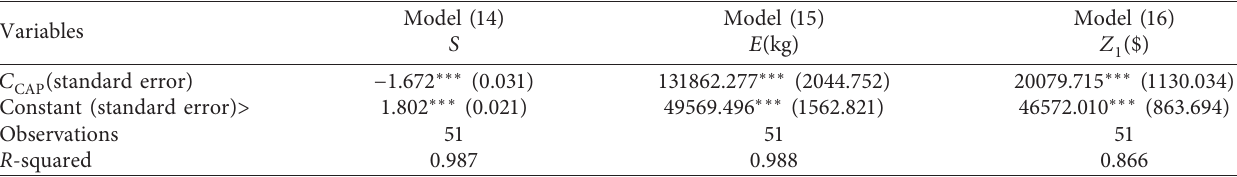
Table 4: Regression results under carbon cap regulation.